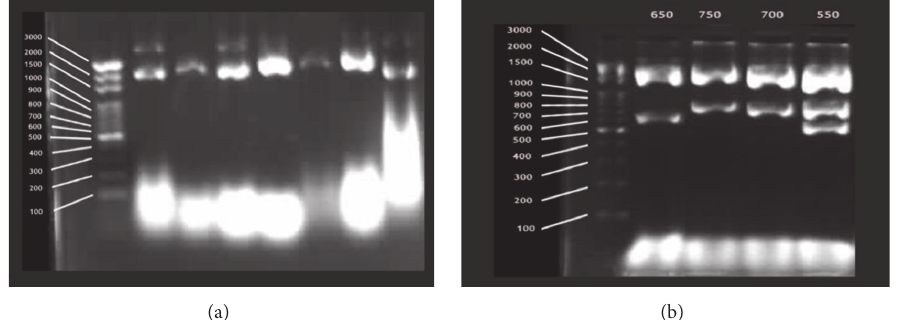
Figure 1: (a) Prenatal cDNA clones obtaining with alkaline lysis method. (b) Cutting of prenatal cDNA clones with Bsp1407I restriction